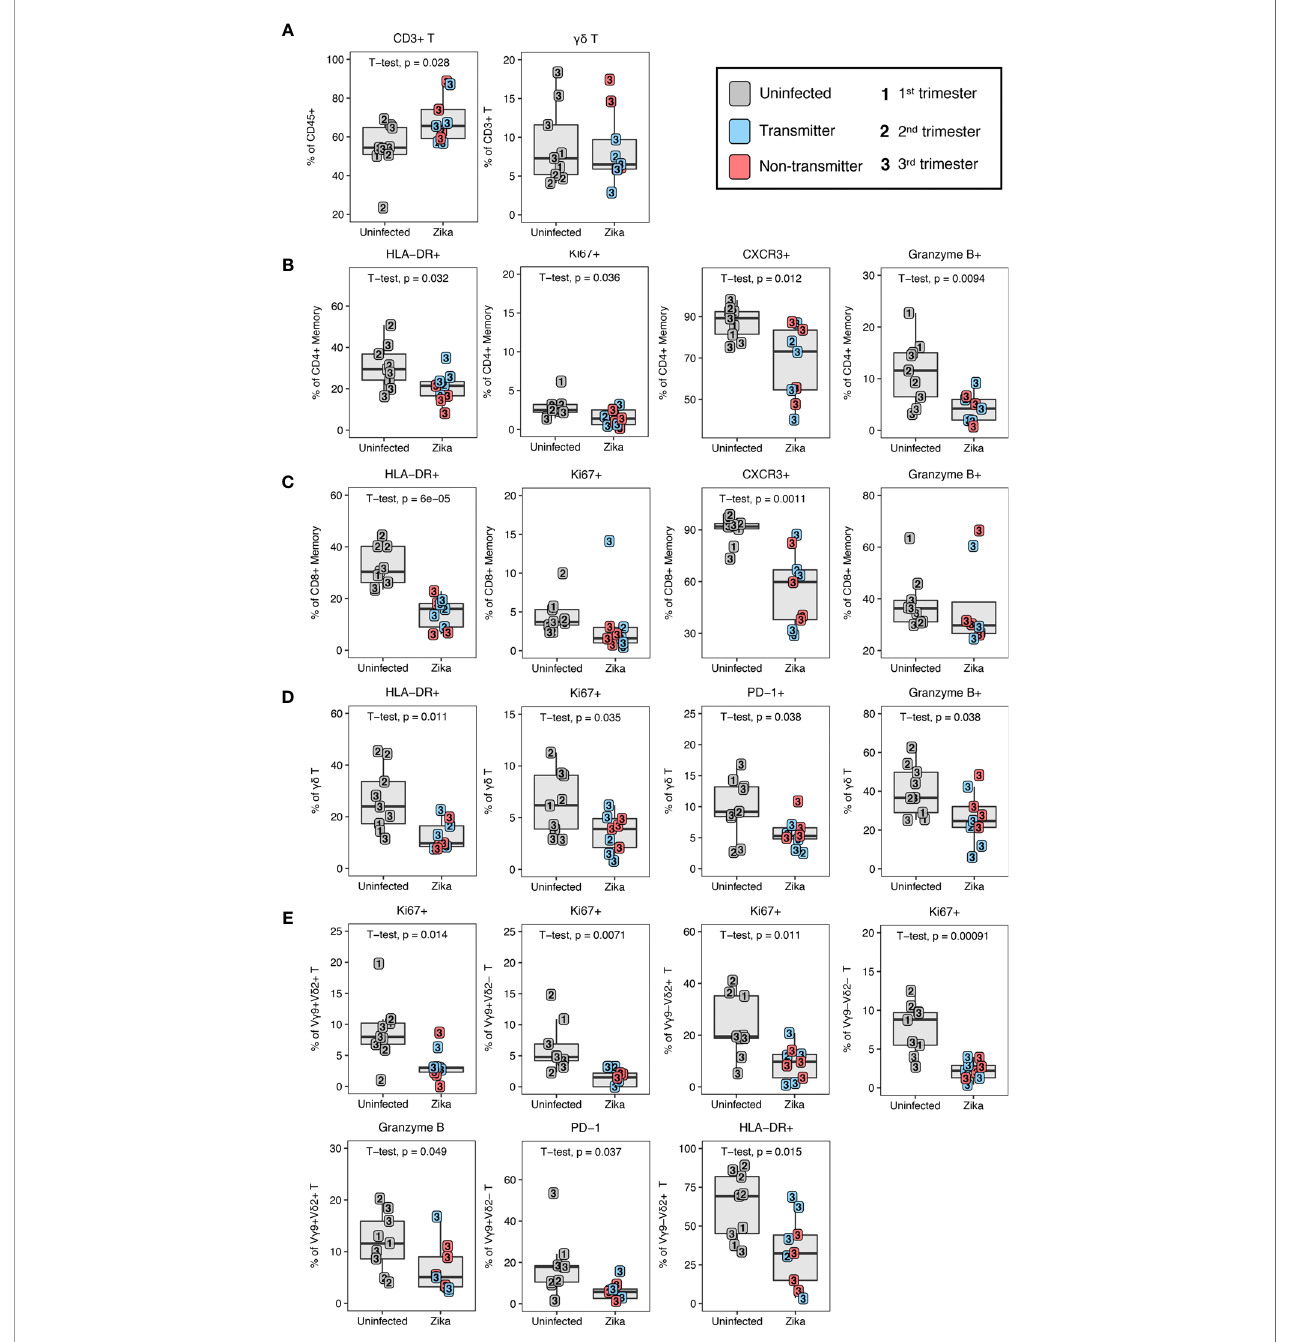
FIGURE 11 | T lymphocyte changes in ZIKV-infected macaques. (A) T and gd T lymphocytes in uninfected (n = 9) (grey) and ZIKV-infected (n = 9) decidual leukocytes. In the ZIKV-infected group, animals with detected amniotic fl uid transmission displayed in blue and non-transmitters in red (B) Decreased activation of CD4+ T memory in the ZIKV-infected group. (C) Decreased activation of CD8+ T memory in the ZIKV-infected group. (D) Decreased activation of gd T lymphocytes in the ZIKV-infected group. (E) Decreased decidual gd T lymphocyte subset activation in ZIKV-infected macaques. P-values < 0.05 (unpaired t-test) shown on the